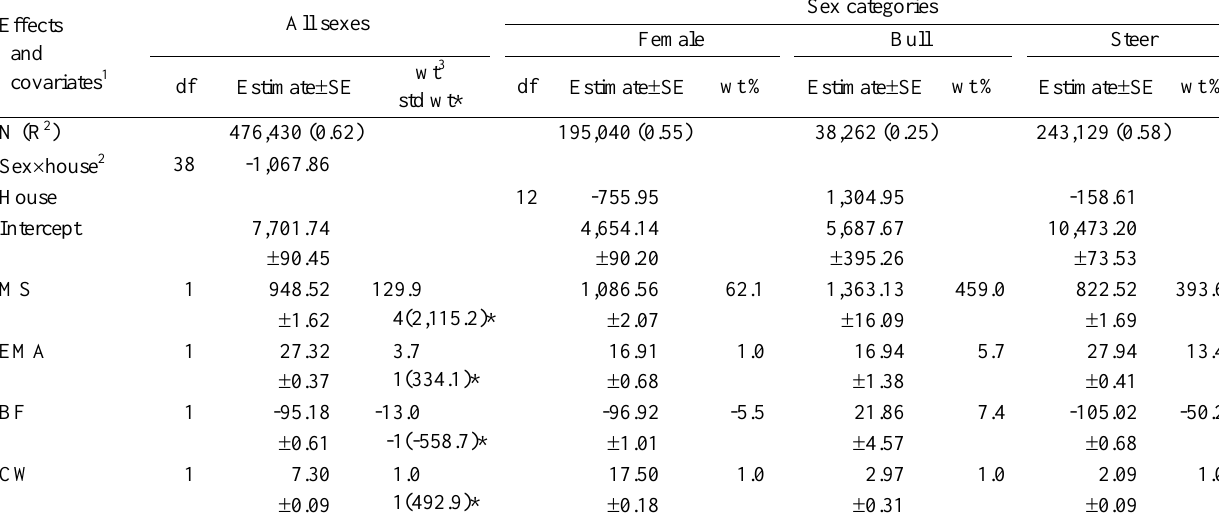
Table 4. Parameter estimates from different models (dependent variable: price/kg carcass)